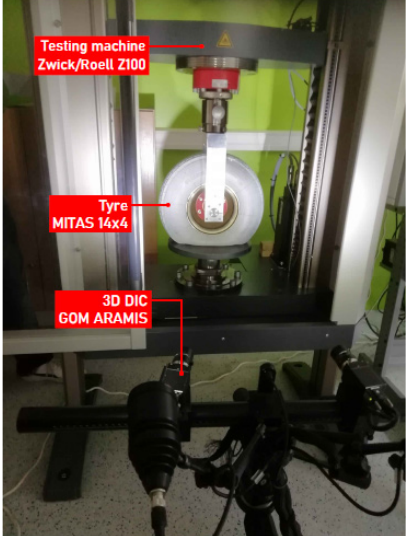
Figure 3. Stand for static aircraft tyre deformation tests